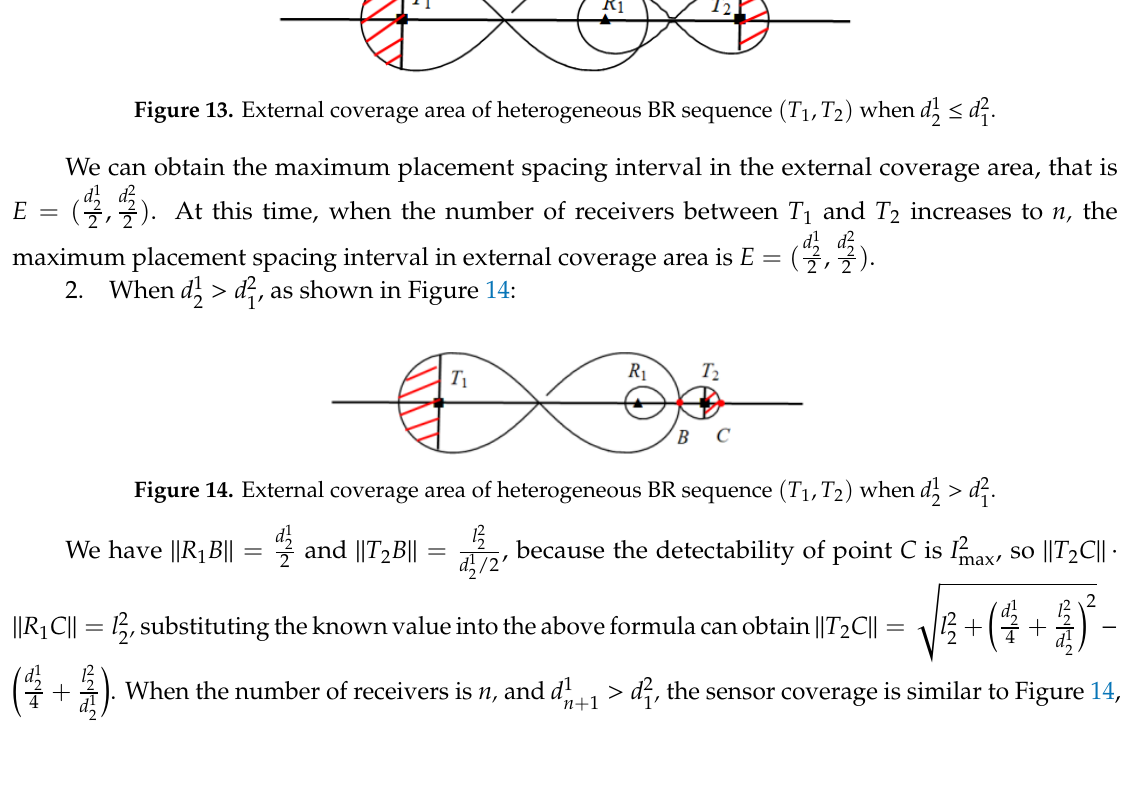
the above can obtain